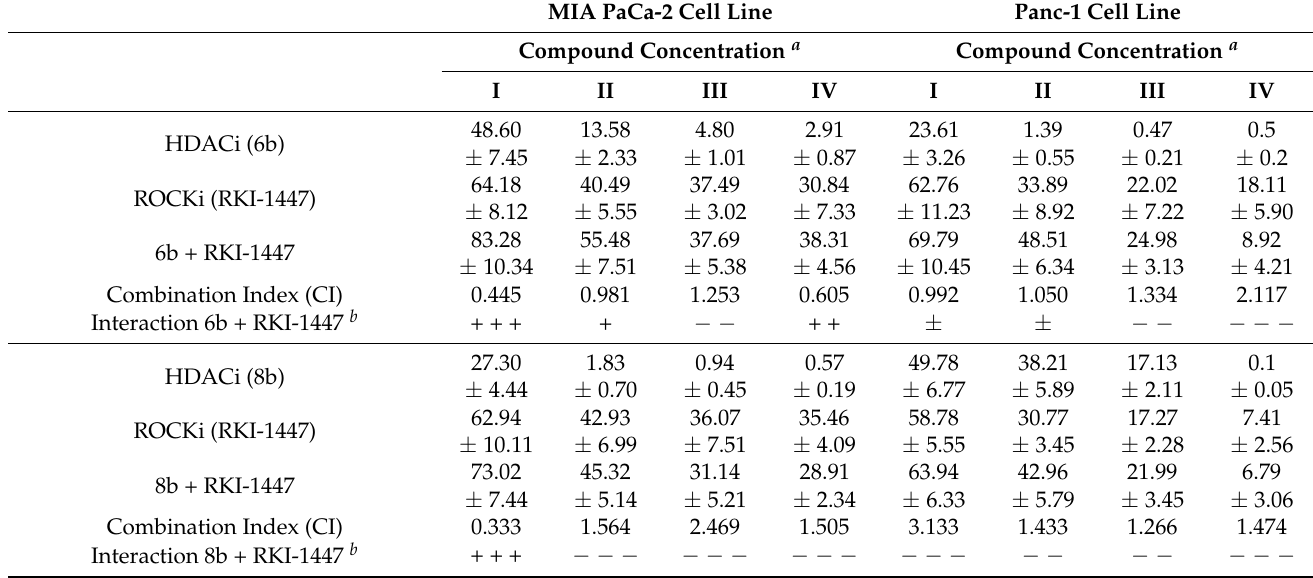
Table 3. Synergism analysis for combination of novel HDACi and RKI-1447. MIA PaCa-2 Cell